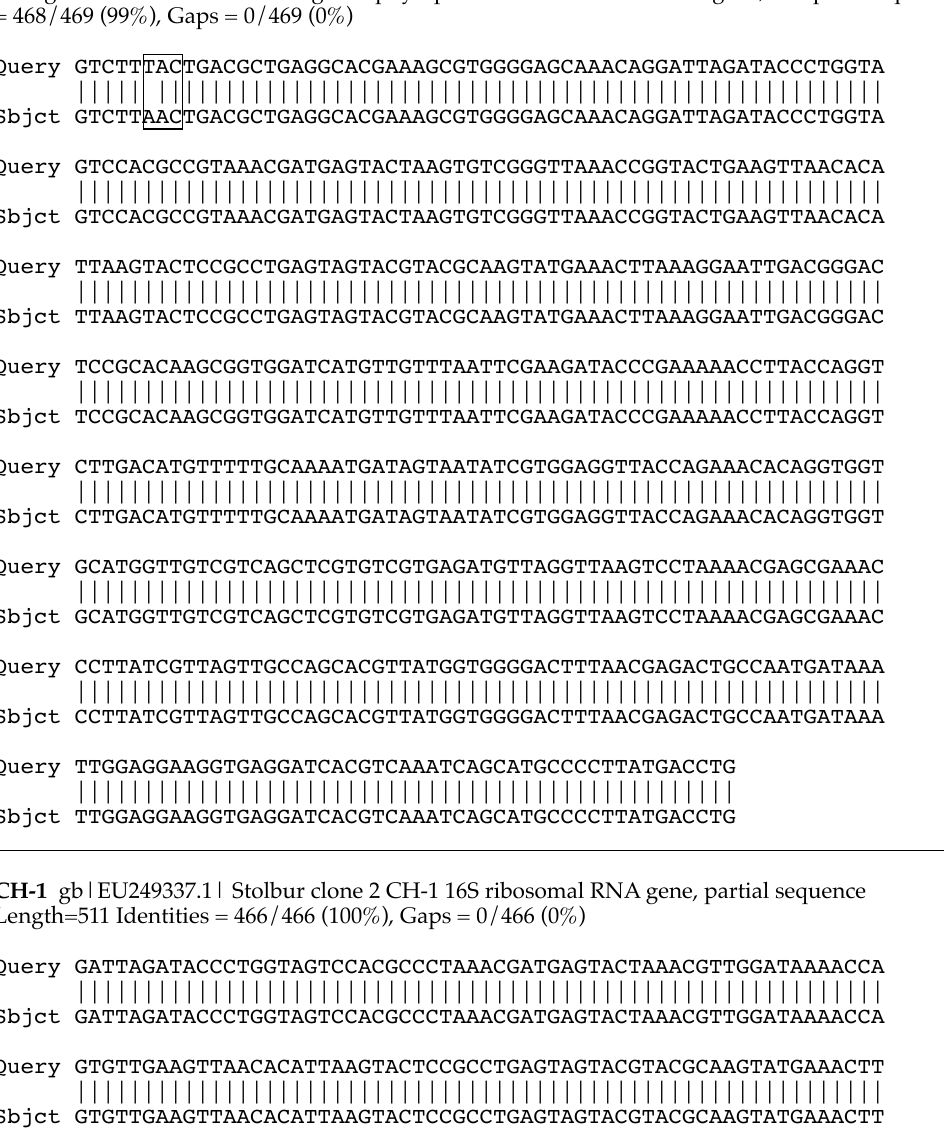
Table 3. Comparison of nucleotide sequences obtained from phytoplasma colonies with those of original phytoplasmas in